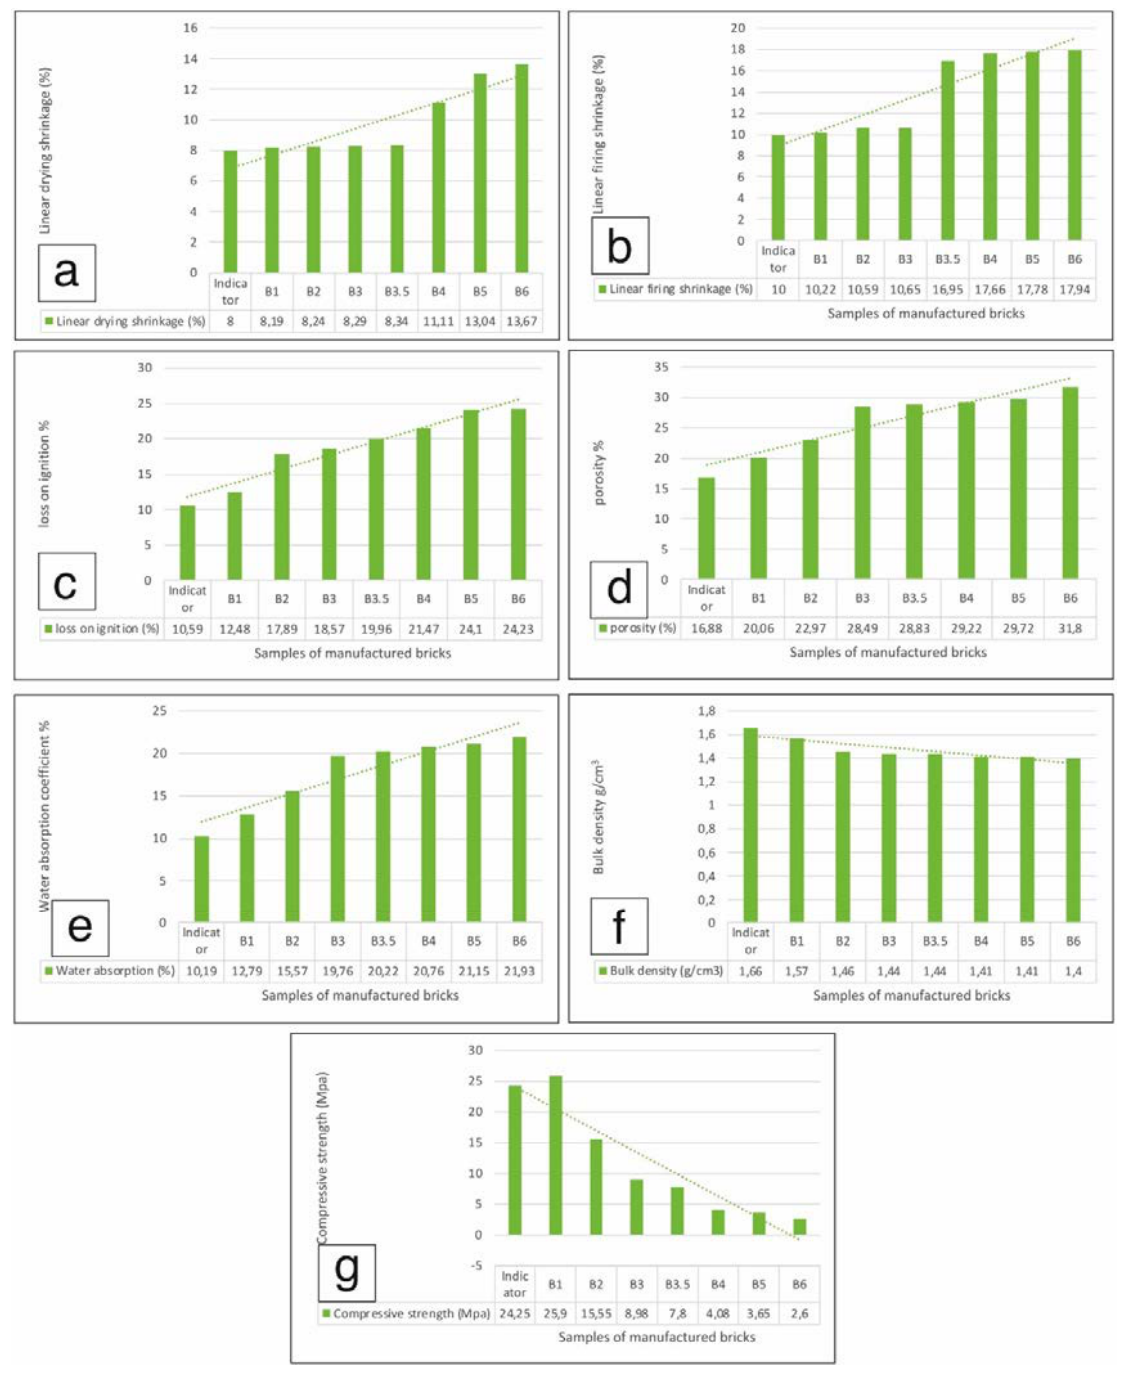
Fig. 4: Qualification tests of the different substitutions of the prepared sludge–clay bricks, B1(10%), B2(20%), B3(30%), B3.5(35%), B4(40%), B5(50%), and B6(60%) compared with the control sample. (a) linear drying shrinkage (%), (b) linear firing shrinkage (%), (c) loss on ignition (%), (d) porosity (%), (e) water absorption coefficient (%), (f) bulk density (g/cm 3 ), and (g) compressive strength (MPa).